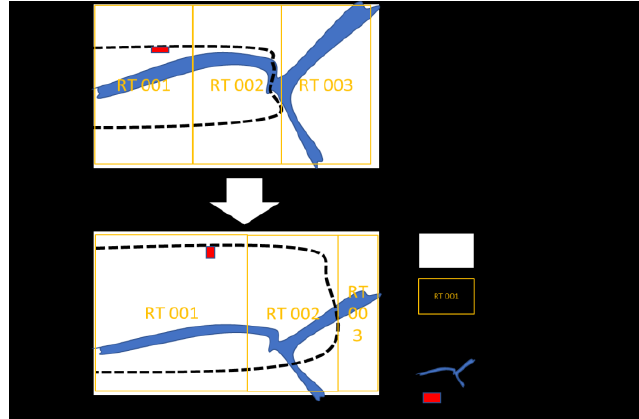
Fig. 4. Illustration of alignment with landmark, road, and